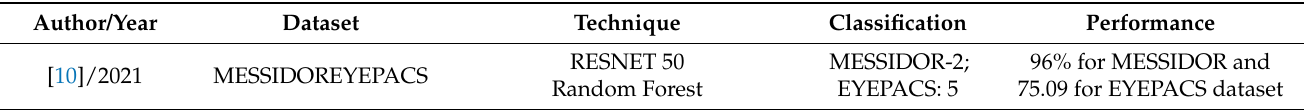
Table 1. Related work for the classification of DR and